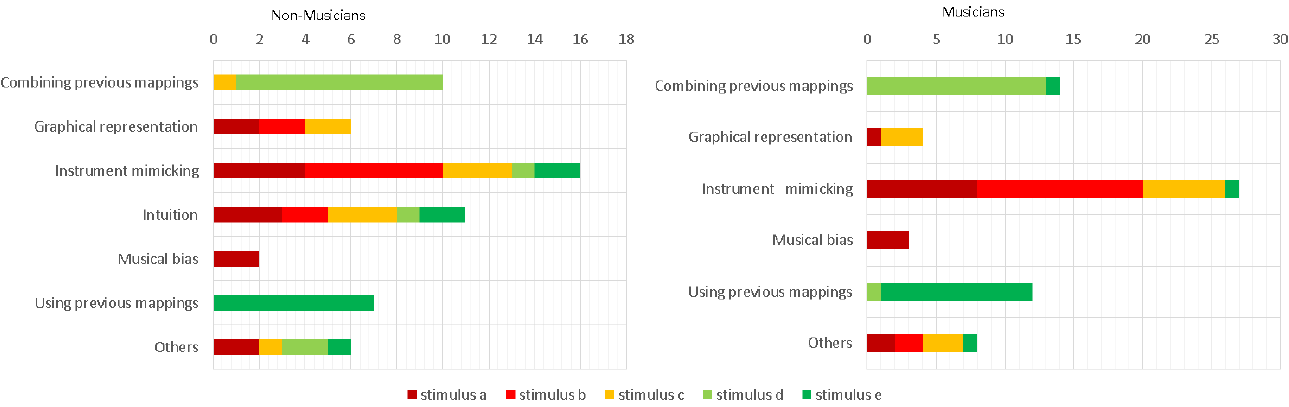
Figure 8. Frequencies of rationale evoked by participants for the gestures performed for each stimulus in phase 2. Left : Non-musician participant frequencies; Right : Musician participant frequencies; Full results reference: Tables